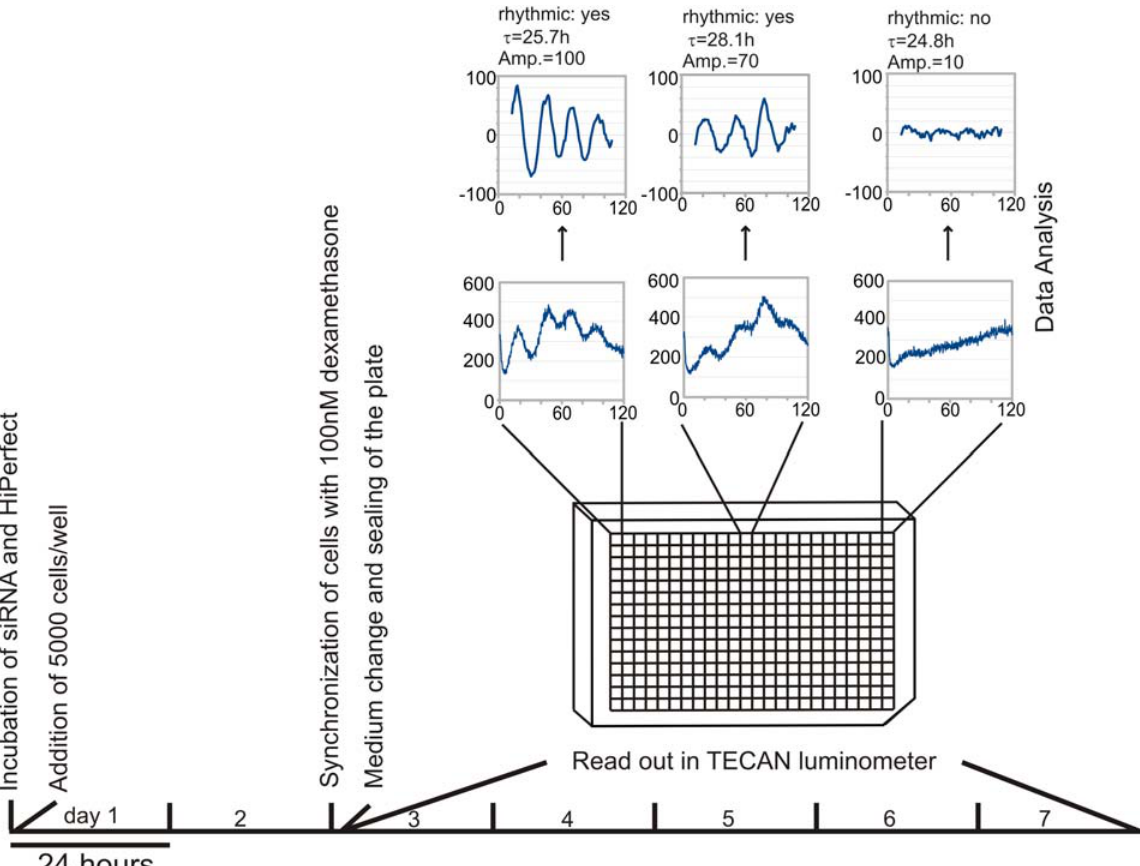
Figure 1. Schema of the kinetic 384-well siRNA assay timeline. Two days after transfection as described in the materials and methods, cells are shocked and subjected to continuous luminescence measurements for 5 days, following which the data is detrended and analyzed.